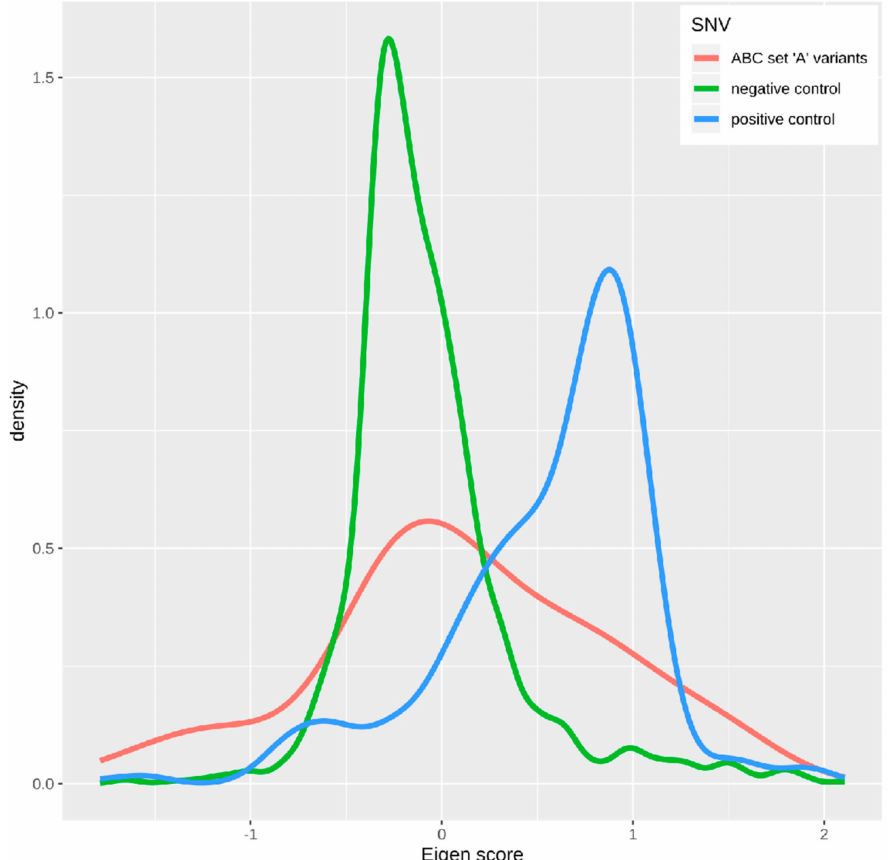
Figure 6. Eigen score distribution of functional genetic variants. Density plot of the distribution of Eigen scores for three di ff erent datasets of single nucleotide variations (SNV). Red line: variants assigned to the ABC set “A” in the feature selection ( d = 36; two variants not in the Eigen database). Blue line: variants causally involved in hereditary syndromes with insensitivity to pain. Green line: random sample drawn from a generic dataset comprising Eigen scores of variants across the human genome queried Eigen score database (http: // www.columbia.edu / ~{}ii2135 / eigen.html). The figure has been created using the R software package (http: // CRAN.R-project.org / (R Development Core Team, 2008)) and the library “ggplot2” (https: // cran.r-project.org / package = ggplot2 (Wickham,